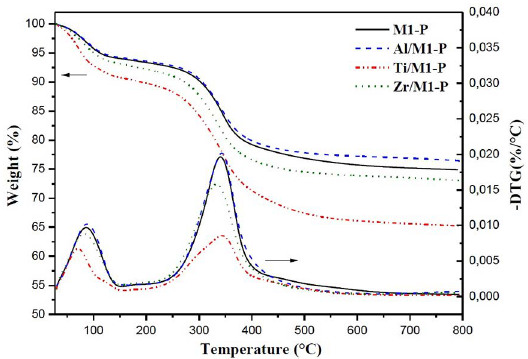
Figure 11. TG/DTG curves of the samples M1-P, Al/M1-P, Ti/M1-P and Zr/M1-P.